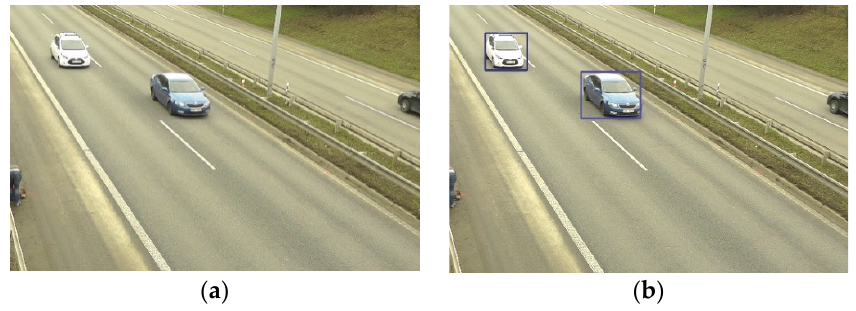
Figure 2. Object localisation performed by YOLOv5 nano: ( a ) input image; ( b ) the result bounding boxes over the